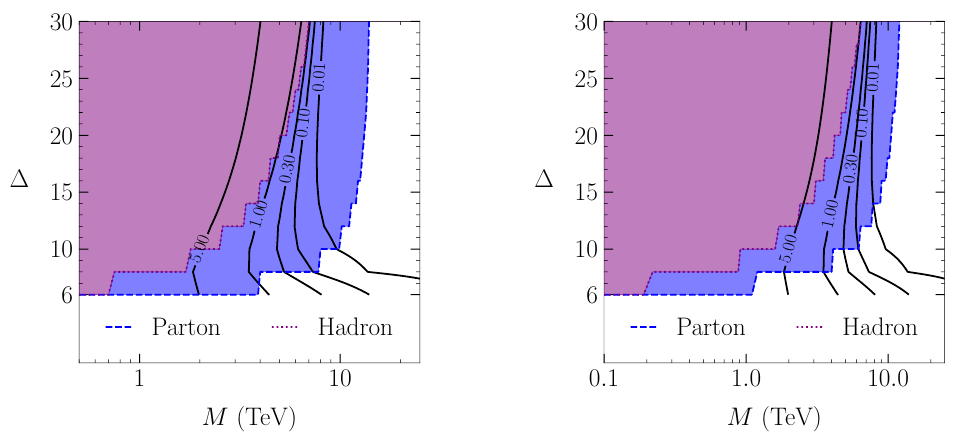
Figure 17 . A comparison of the perturbative unitarity results against the s -channel cross section predictions for two choices of the UV parameters: λ q = 2 [left] and λ q = 2 / (4 π ) [right]. The shaded regions are the perturbative unitarity bounds. The contours show constant power counting uncertainty. This provides evidence that valid EFTs exist in the region excluded by the naive partonic perturbative unitarity